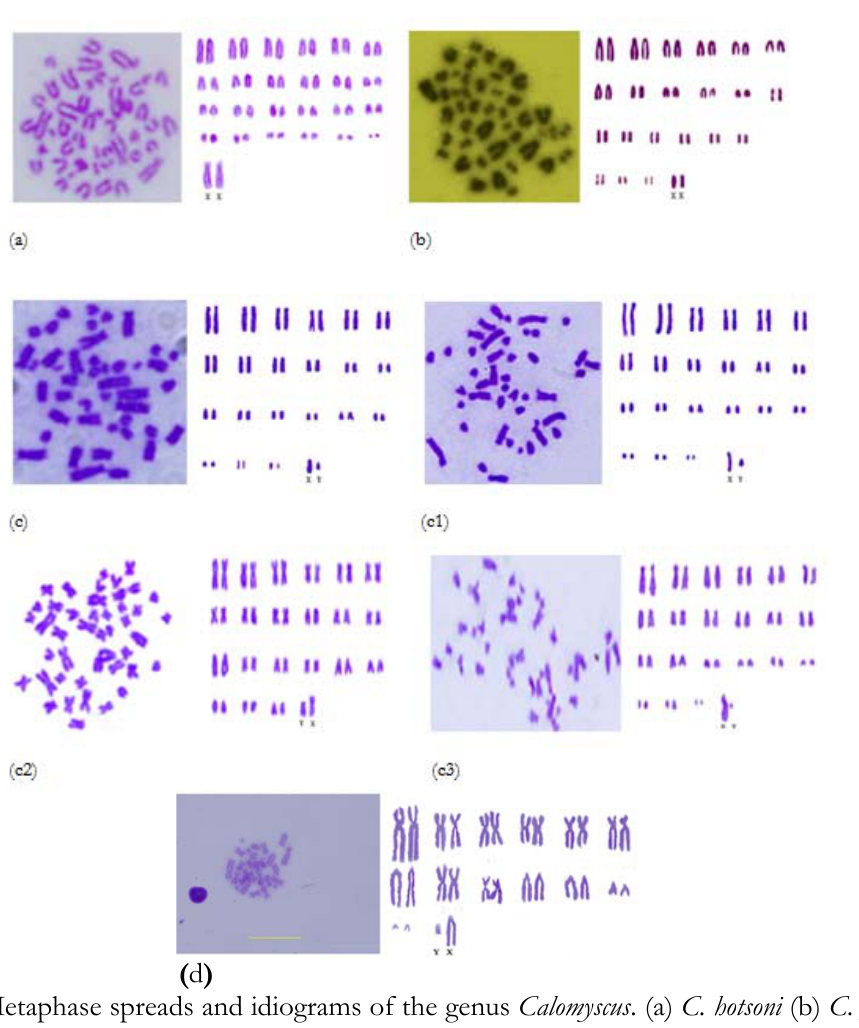
F IGURE 12. Metaphase spreads and idiograms of the genus Calomyscus . (a) C. hotsoni (b) C. grandis